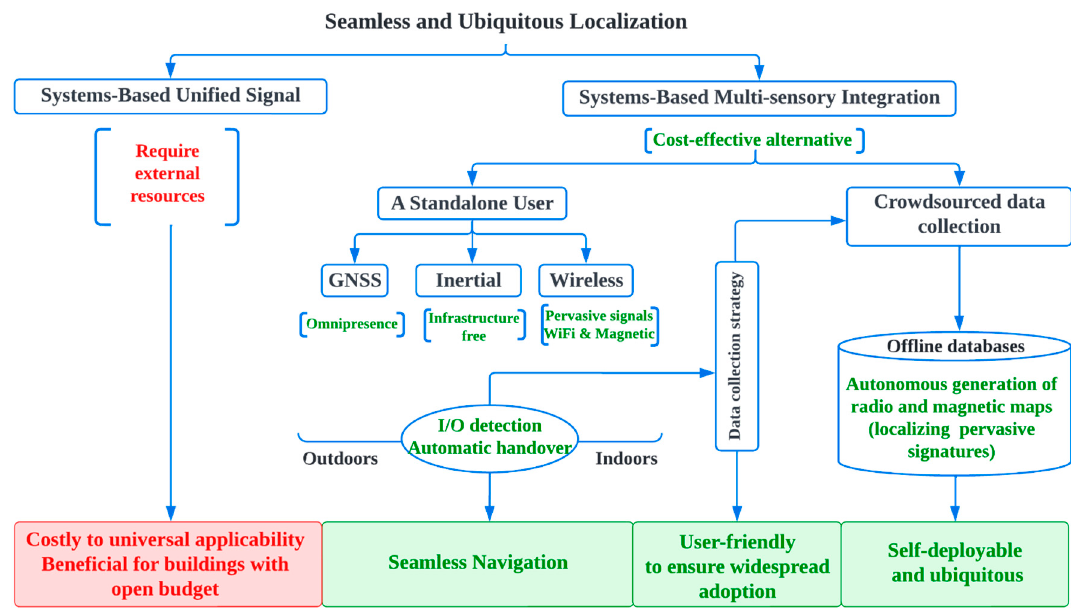
Figure 1. Classification of seamless and ubiquitous localization systems.